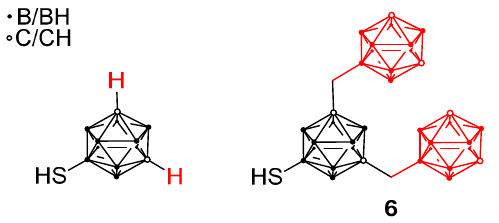
Figure 2. Comparison between 9-mercapto-1,7-dicarba- closo -dedecaboran(12) (left) and 1,7-bis(1,7-dicarba- closo -dodecaboran-9-ylmethyl)-1,7-dicarba- closo -dodecaboran-9-yl-thiol ( 6 ) (right) (altered fragments are drawn in red).